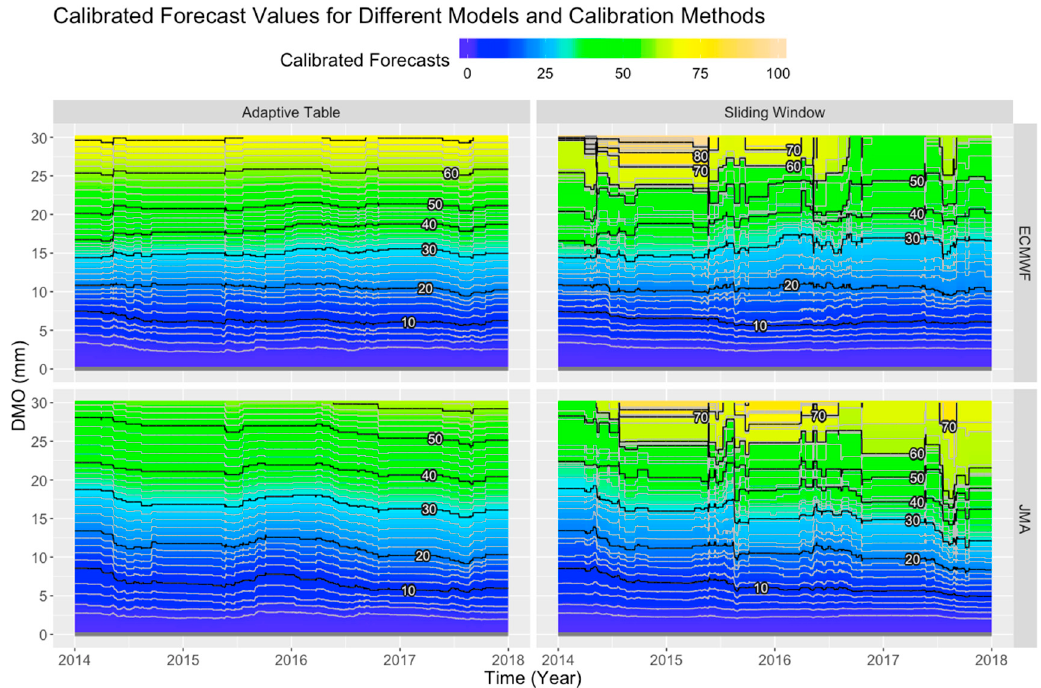
Figure 3. Calibrated values that would be obtained given different DMO values at different times, by calibration method and by model. Grey and black contours are in intervals of 2 and 10 mm respectively, starting from 0 mm at the bottom.